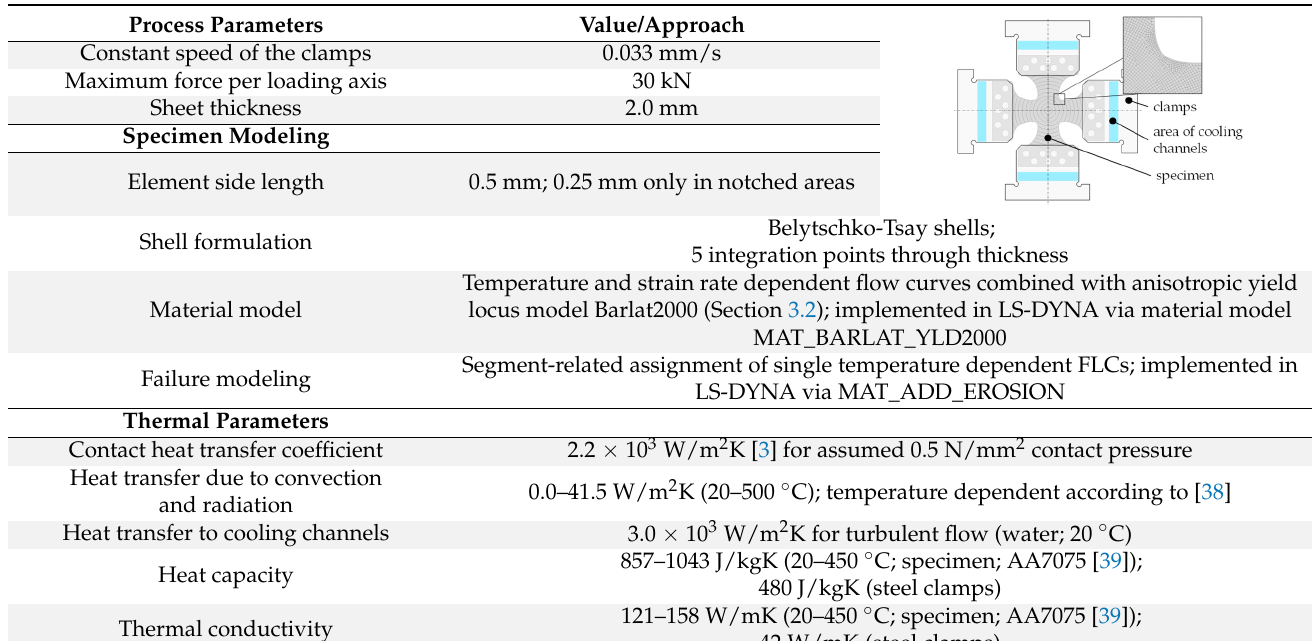
Figure 5. Assumption for TFLDs for AA7075 according to Rong et al. [37] and Ying et al. [17].